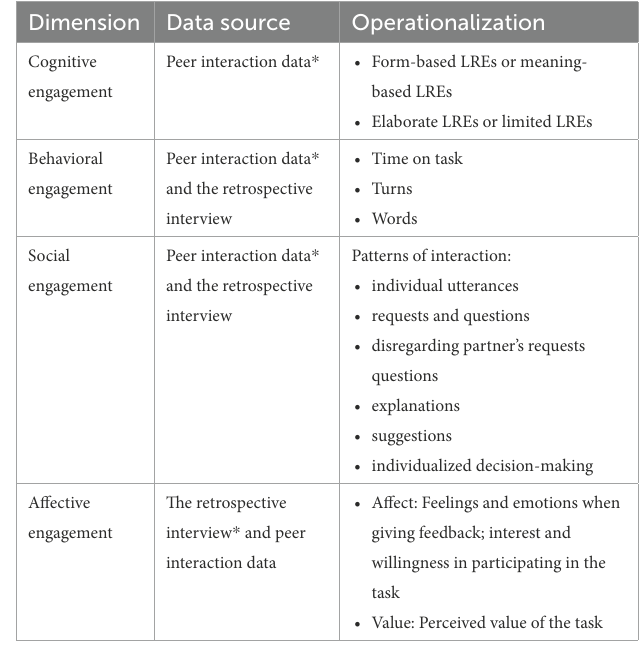
TABLE 2 A summary of the analysis of